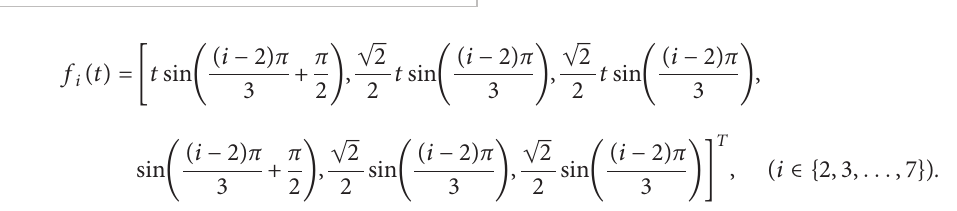
Figure 3: Trajectories of δ